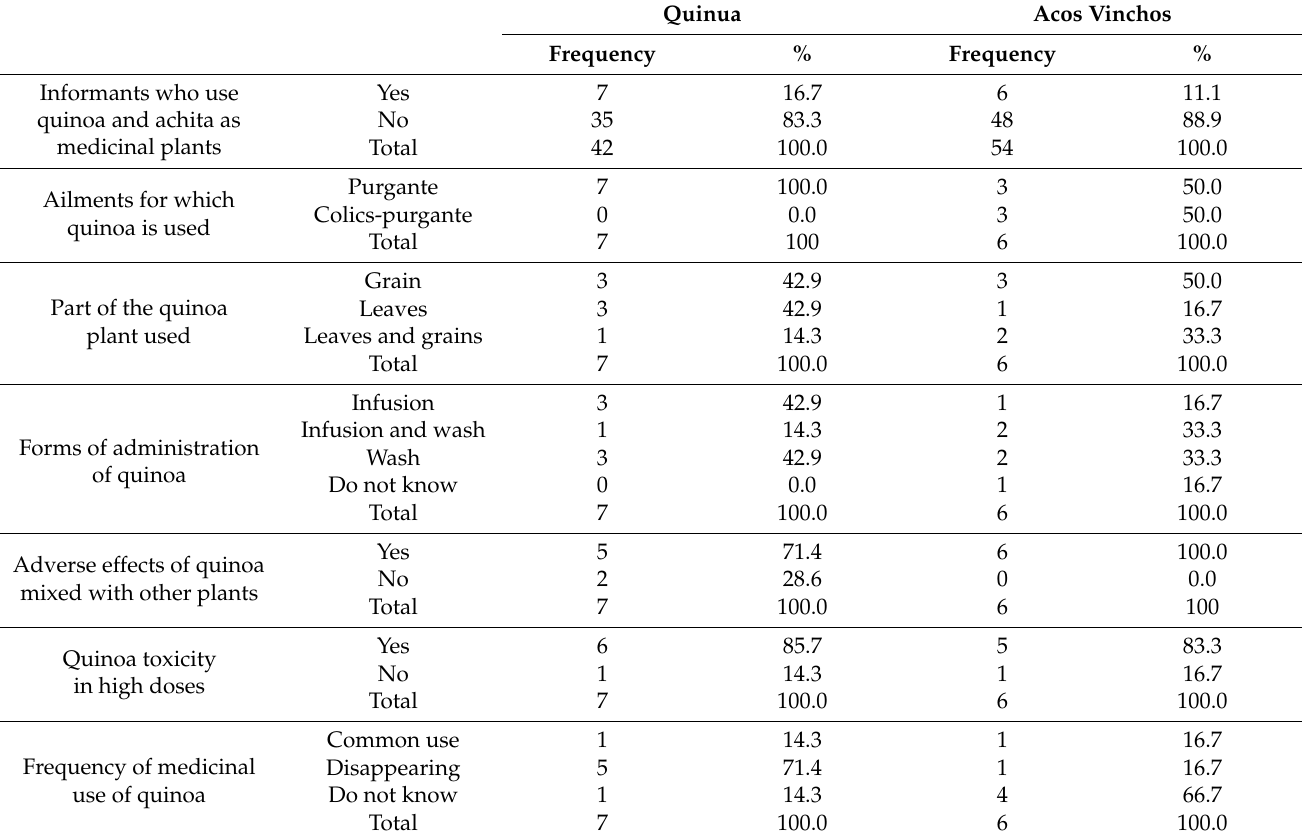
Table 5. Medicinal use of ancestral Andean grains in the districts of Quinua and Acos Vinchos.